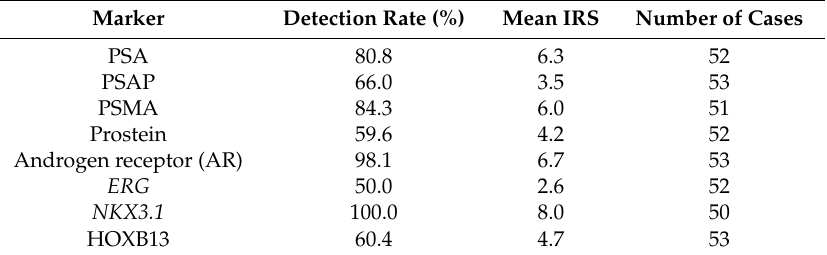
Table 1. Detection rates of prostate markers in prostate cancer metastases.